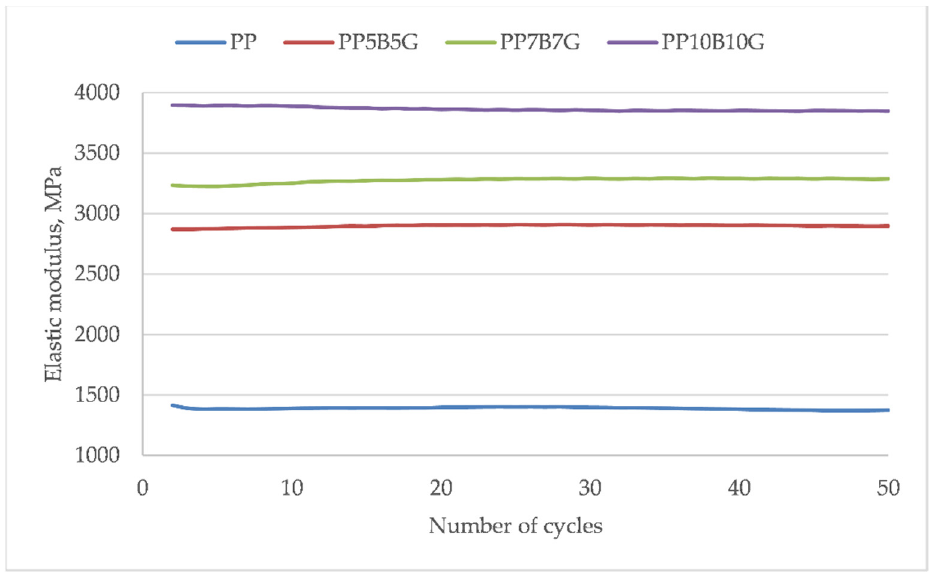
Figure 11. Elastic modulus of successive hysteresis loops of sample load and unload.